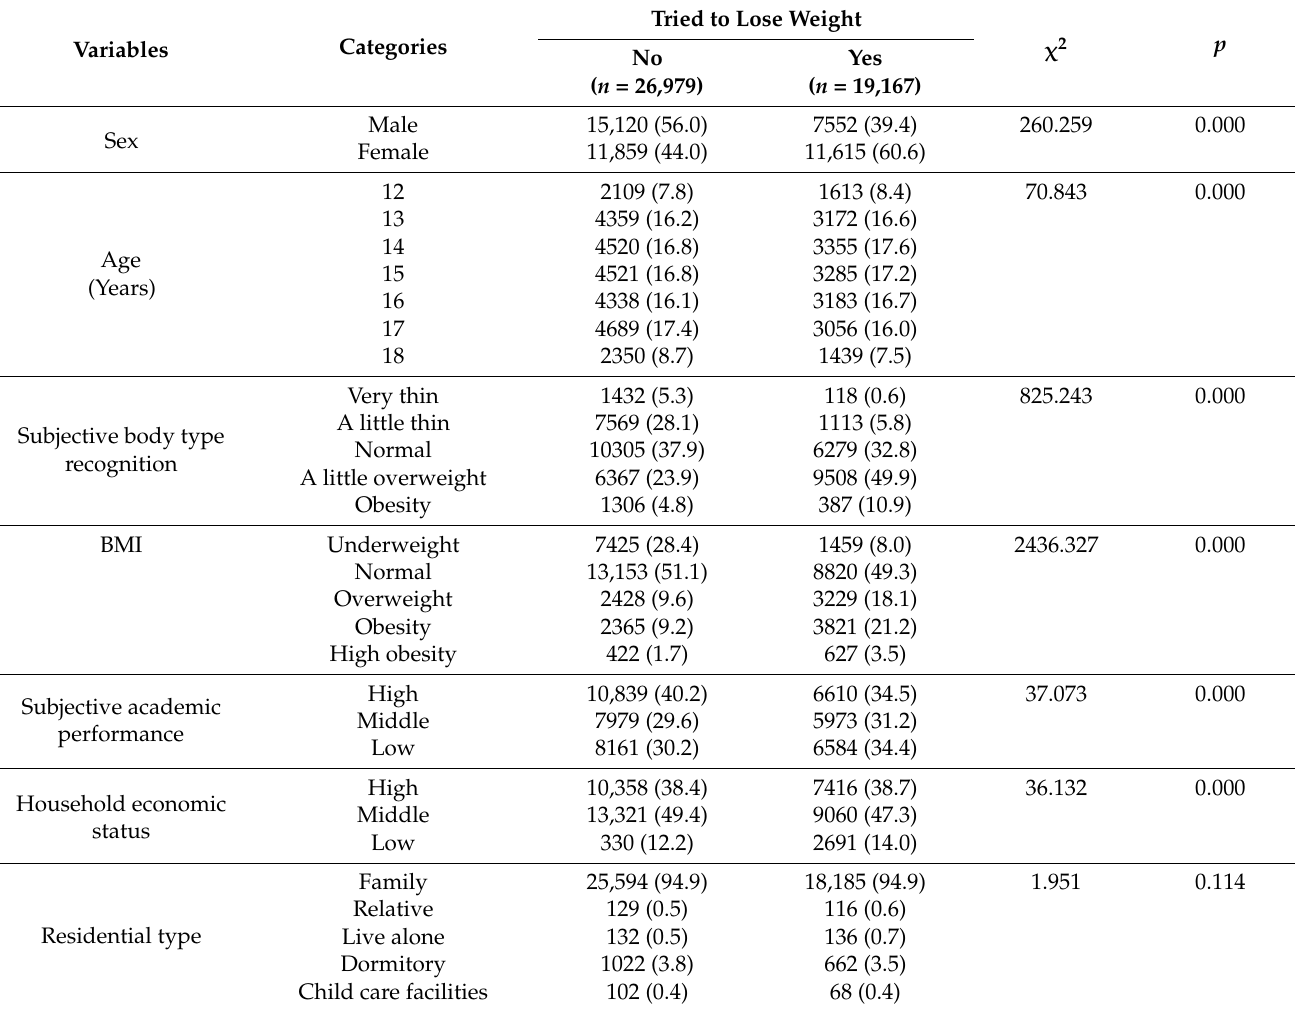
Table 1. General characteristics according to losing weight effort within the last one